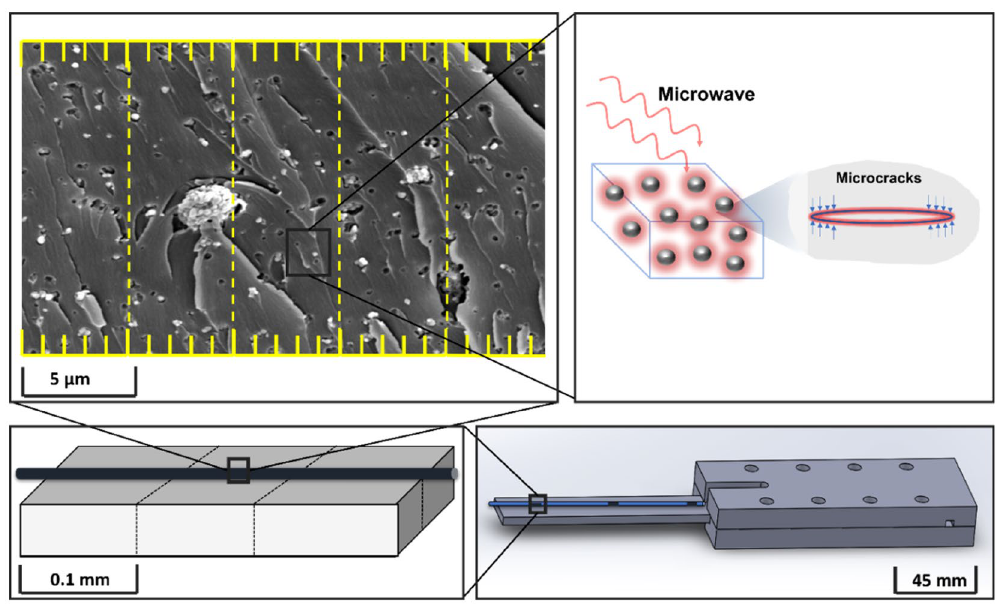
Figure 30. Schematic of the 15 wt.% BaTiO 3 -epoxy nanocomposite under exposure at different